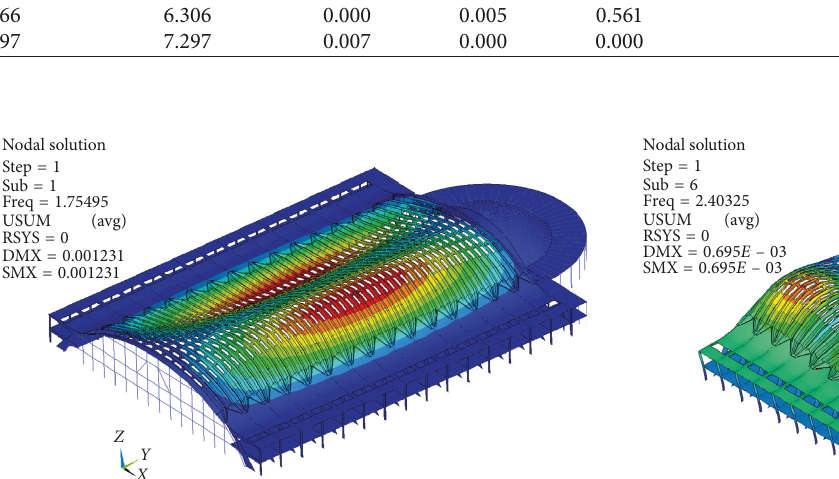
Figure 11: Mode 1 of Hall B in its damaged configuration (front view).